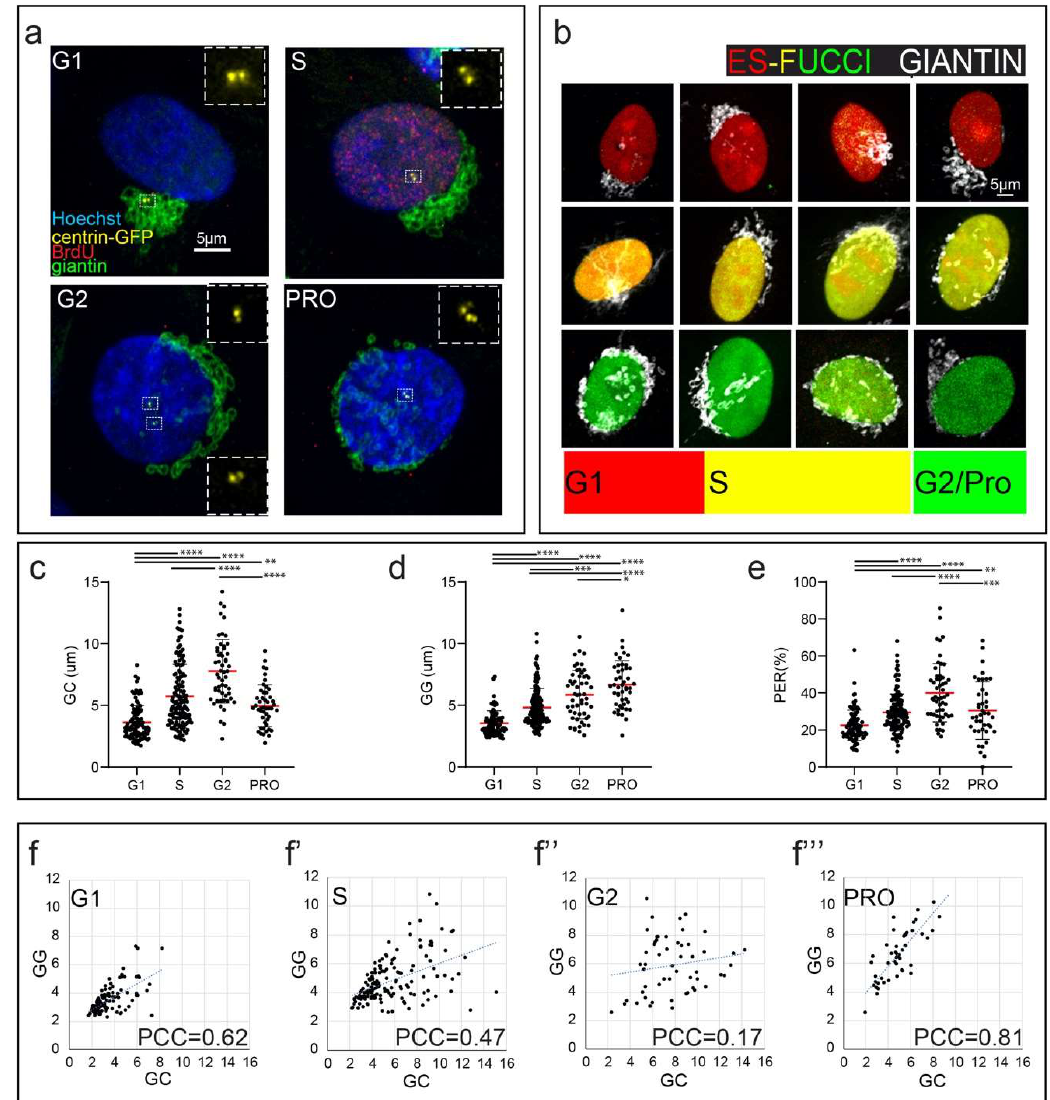
Figure 1. Golgi configuration and centrosome association are cell cycle-dependent. ( a ) Representative images of Golgi and centrosome positioning in specific cell cycle phases (G1, S, G2, prophase (PRO). Immunostaining: Hoechst (blue), centrin1-GFP (yellow), BrdU (red), giantin (green). Boxed regions (centrosomes) are enlarged in insets. Maximum intensity projections of laser scanning confocal stacks. Scale 5 µ m. ( b ) Representative images of Golgi (immunostained, giantin, white) throughout the cell cycle as highlighted by ES-FUCCI cell cycle indicator. FUCCI color code: G1, red; S, yellow, G2 and prophase, green). Maximum intensity projections of spinning disk confocal stacks. Scale 5µm. ( c – e ) Quantification of Golgi and centrosome distribution indices in the fixed cell population based on data